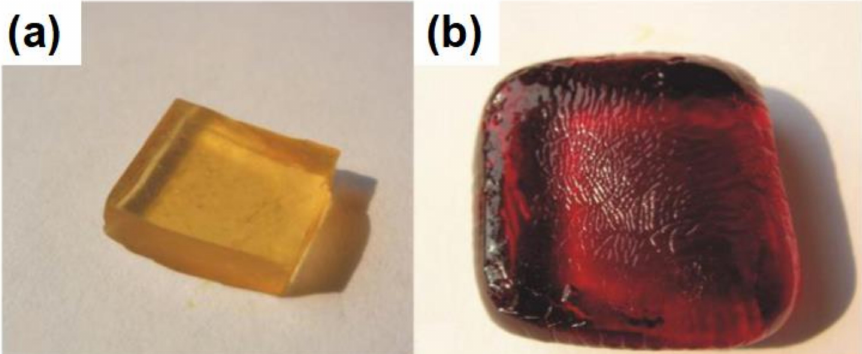
Figure 6. Photographs of thermosetting polymer electrolyte (PAA-PEG / NMP + GBL / NaI + I 2 ): ( a ) Before and ( b ) after soaking in I 3 − / I − liquid electrolyte, respectively (reproduced from Reference [129] with permission, copyright Wiley, 2007).